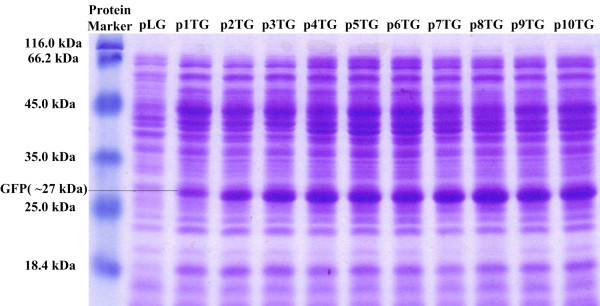
Determination of the GFP expression of the MCPtacs promoter clusters by SDS-PAGE. After 16 h cultivation, cells were harvested and lysed completely in isometric PBS. 15 μL supernatant containing GFP was subjected to SDS-PAGE. GFP bands were measured with ImageJ software, and the areas of their corresponding peaks were used to denote the relative GFP amounts. Lane1 Protein Marker, lane2 5874.43, lane3 12432.74, lane4 14813.91, lane5 17585.91, lane6 18039.91, lane7 18487.33, lane8 17334.79, lane9 16975.38, lane10 20819.62, lane11 18758.20, lane12 20396.74.